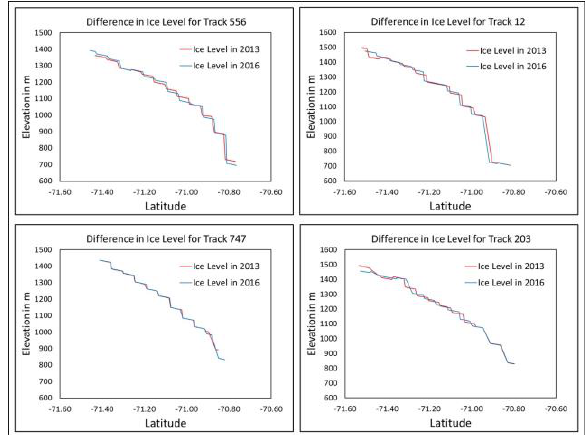
Figure 12. Ice Sheet Elevation profile difference for 2013-2016.